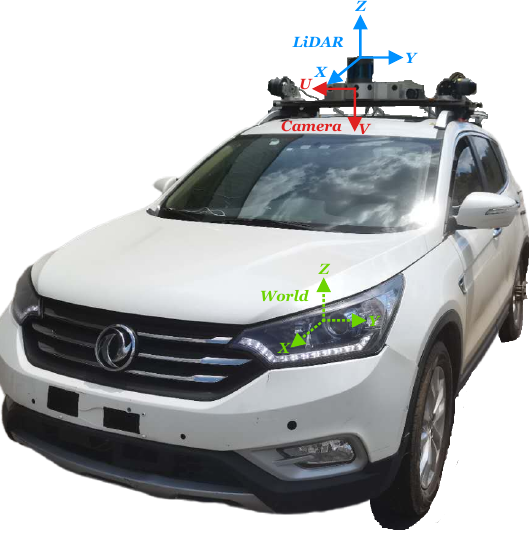
Figure 2. Our autonomous driving vehicle with image coordinate system, LiDAR coordinate system, and world coordinate system in our